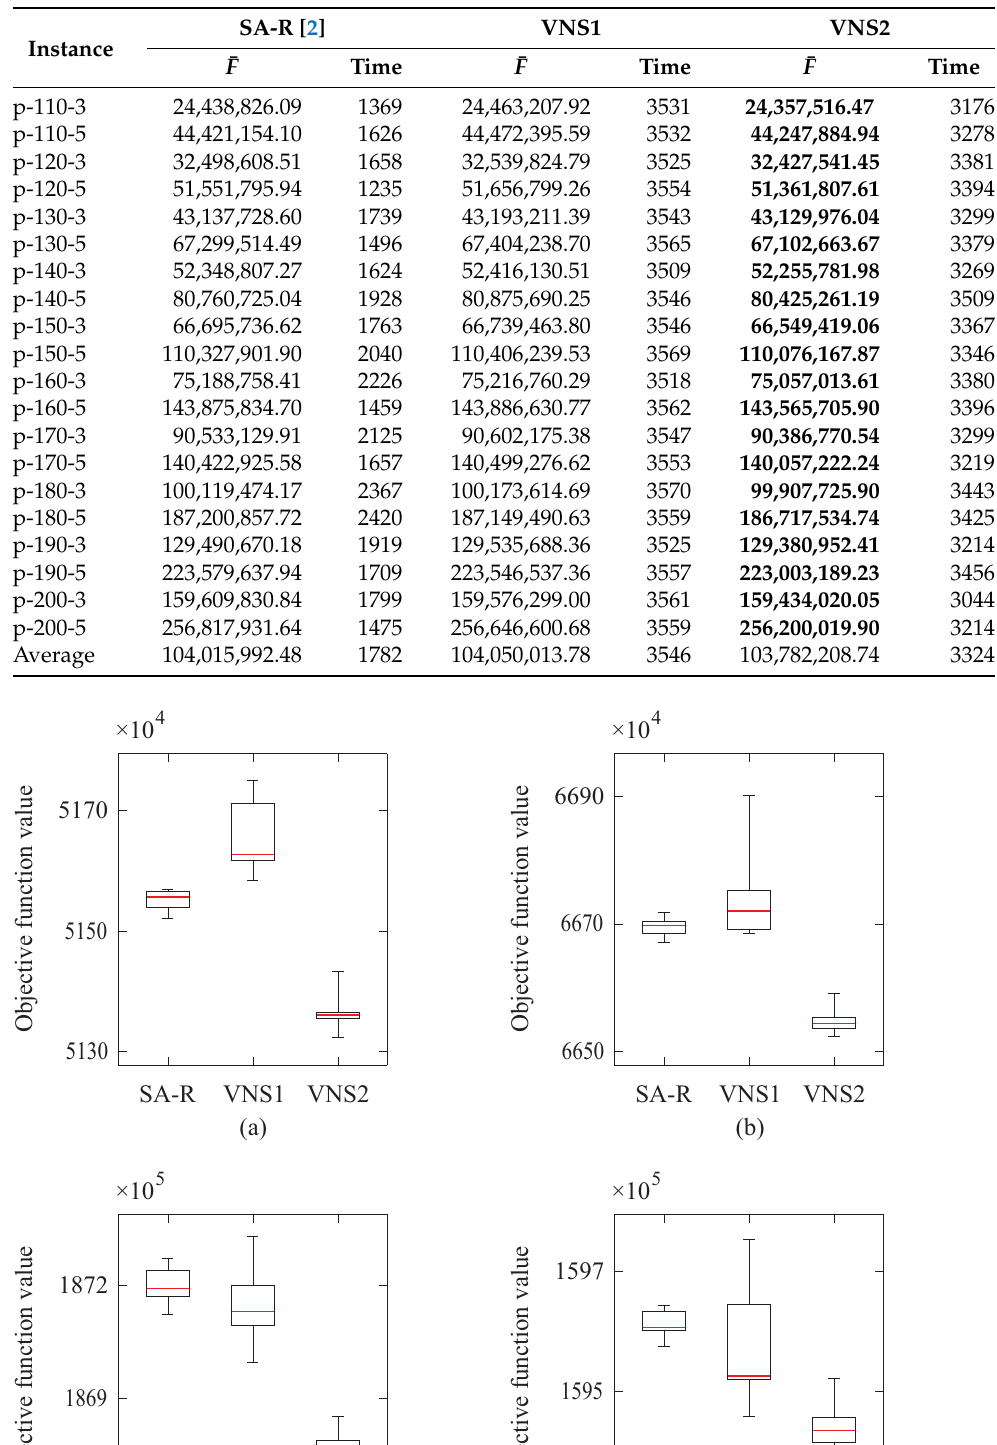
Table 6. Average results of VNS1, VNS2, and SA-R for larger-size instances (the time is in seconds).